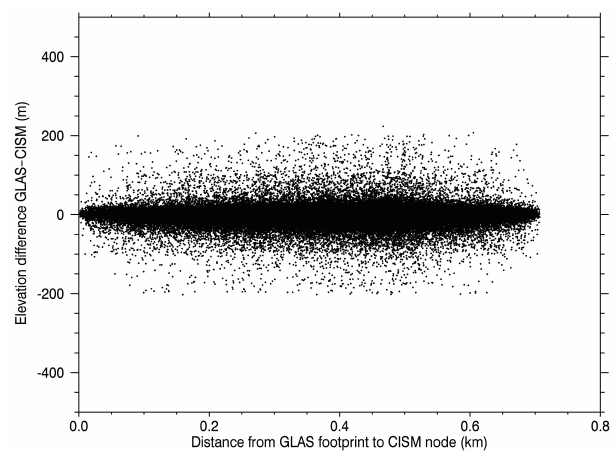
Figure 7. Scatterplot showing difference in model and observation location (km) vs. ICESat minus modeled surface elevation differ- ences (m) in 2007.8 for the SMB + FF